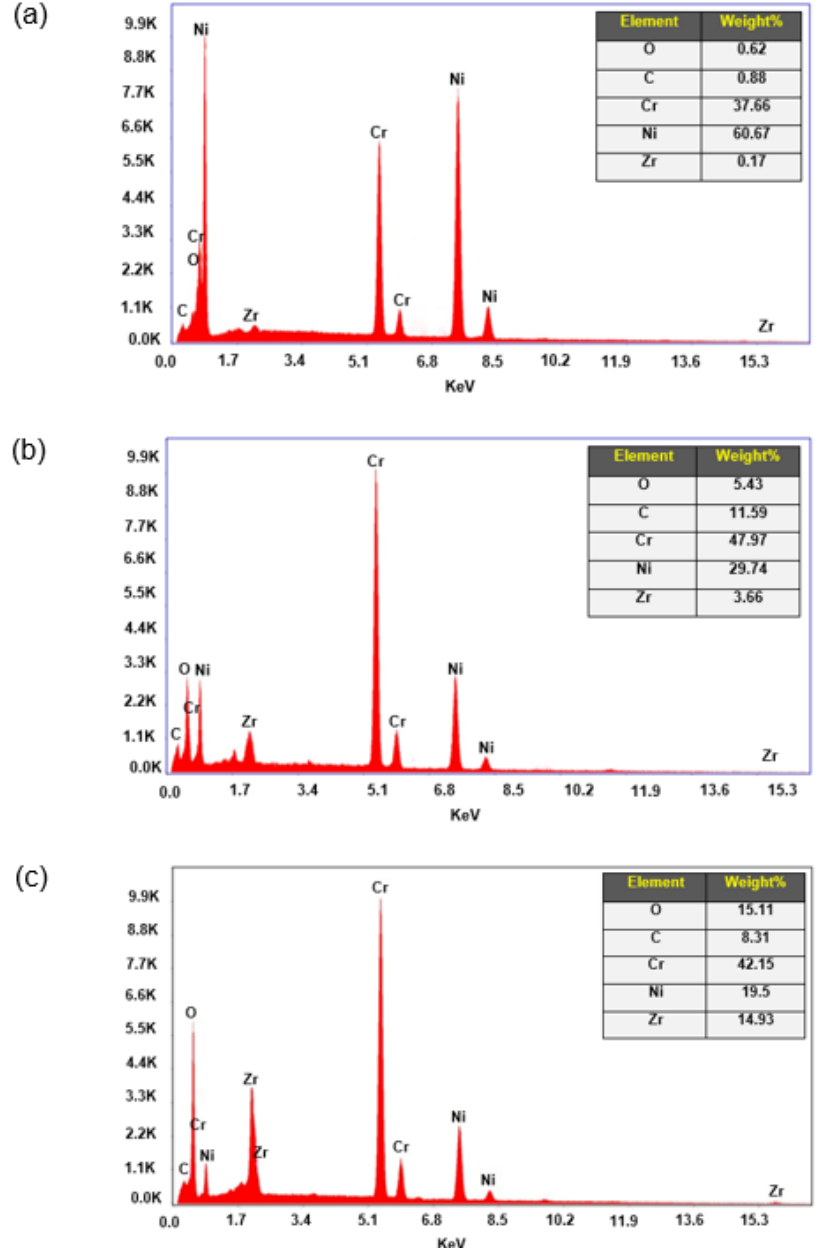
Figure 15. EDS spectra on worn surfaces of the Cr 3 C 2 -NiCr coating under ( a ) 10, ( b ) 20, and ( c ) 30 N applied load.